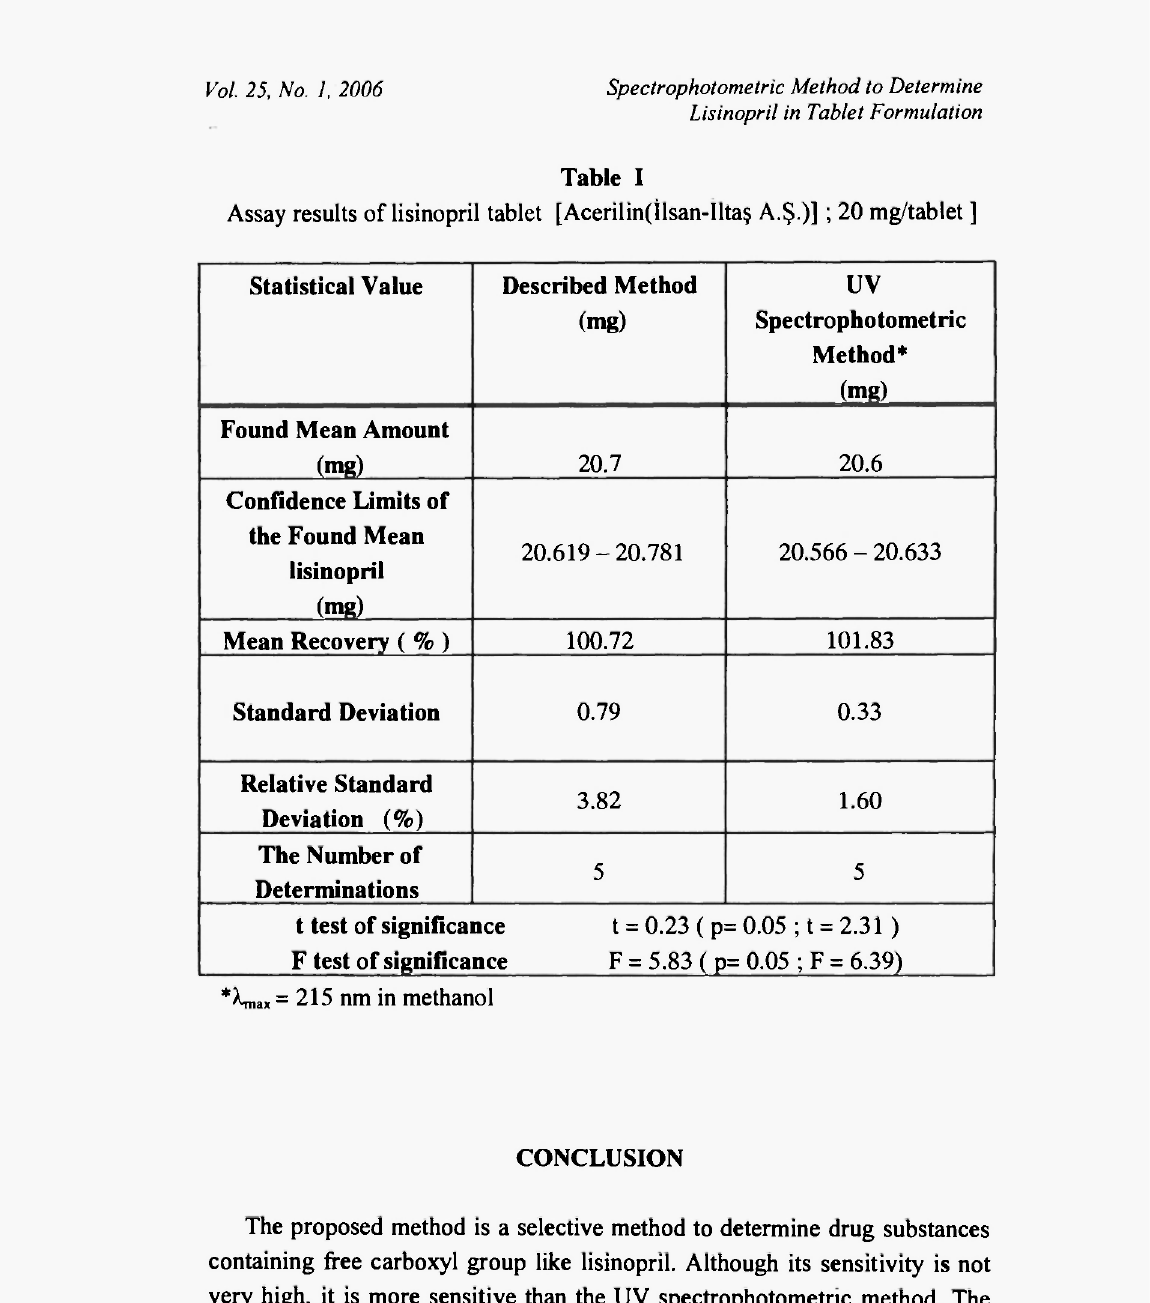
Assay results of lisinopril tablet [Acerilin(ilsan-Ilta§ A.$.)] ; 20 mg/tablet